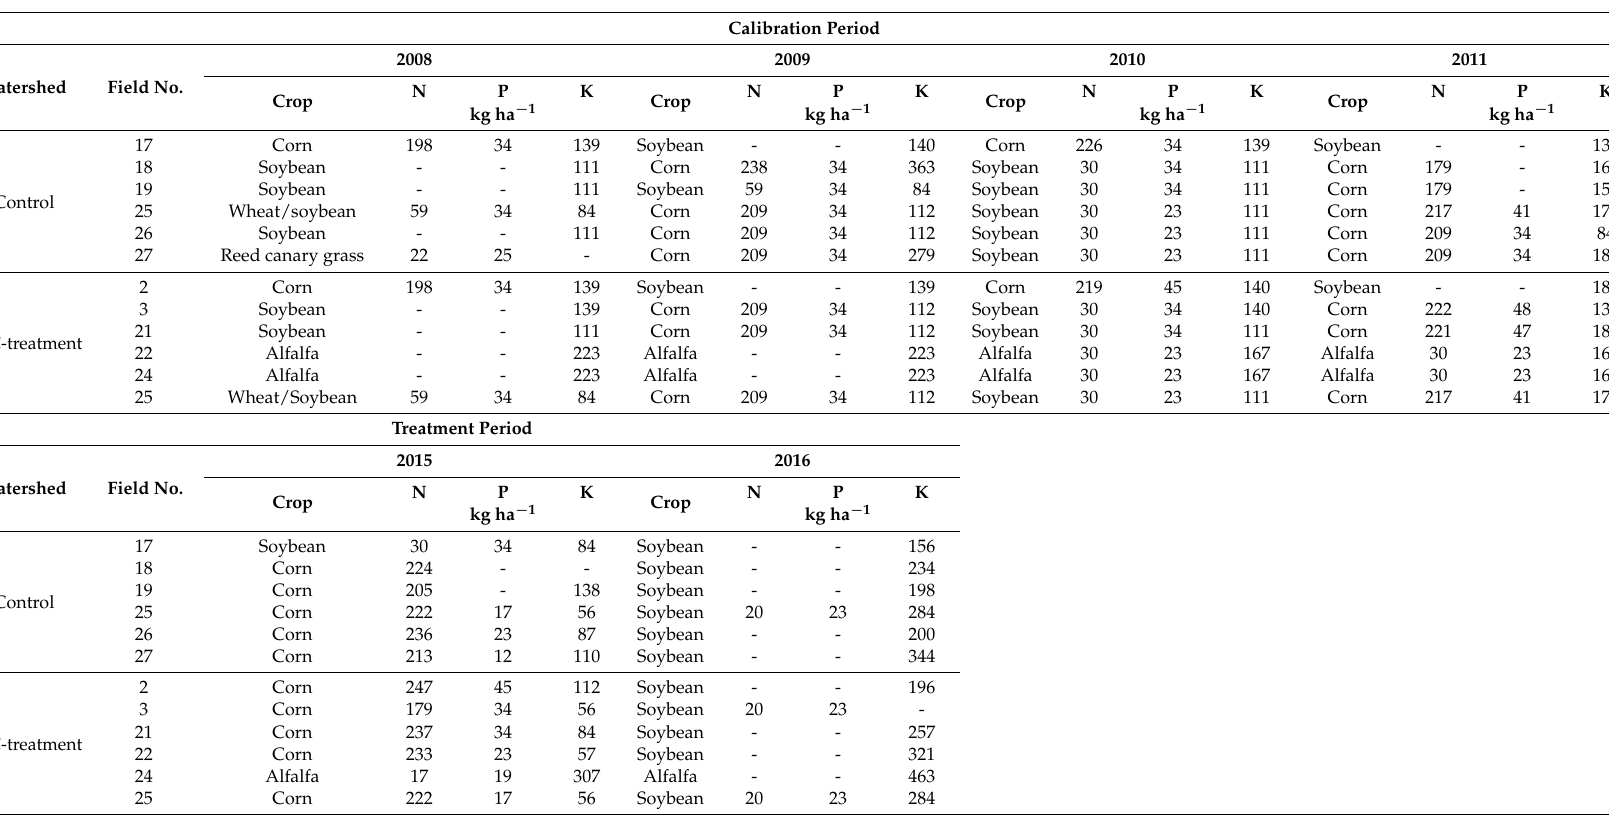
Table 2. Fertilizer application rates for individual fields during calibration and treatment periods. Average NPK rate kg ha − 1 for the calibration period was 130:30:150 and treatment period was 163:26:187,